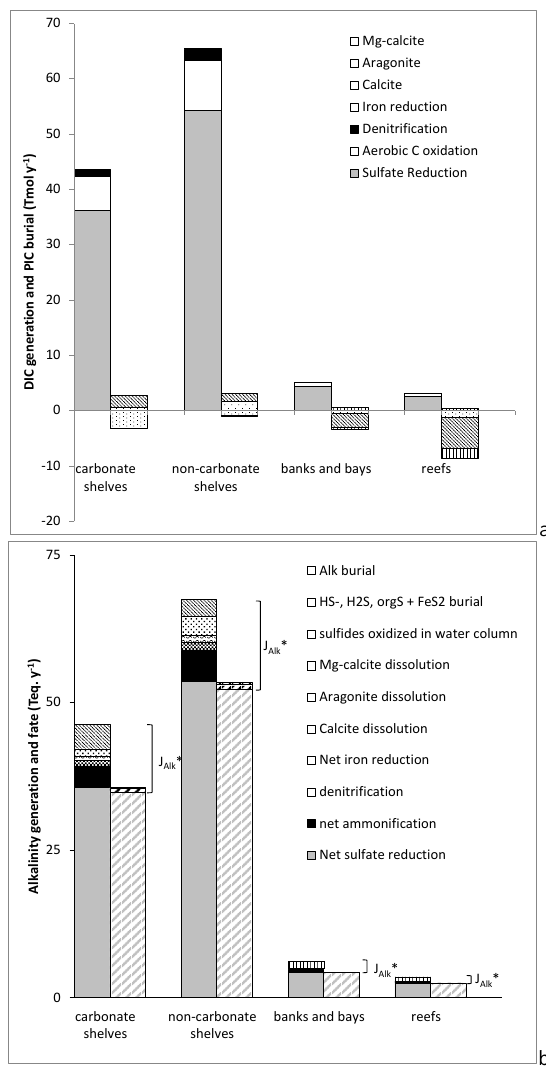
Fig. 4. Generation of DIC (a) and alkalinity (b) , along with the fate of generated alkalinity and PIC by environment. Baseline coastal benthic POC deposition fluxes. (a) first column is DIC generation by C oxidation pathway; second column is PIC dissolution or burial. (b) first column is alkalinity generation by redox reactions and PIC dissolution; second column is the fate of the liberated alkalinity (burial, release to the water column as J Alk ∗ , release to the water column as sulfides). Alkalinity sink due to PIC burial is also indi-